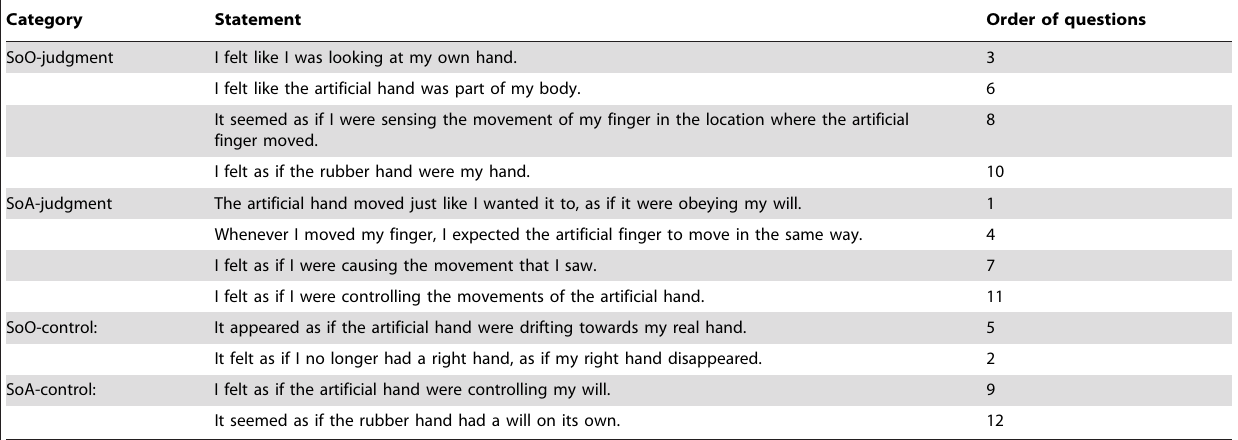
Table 1. Questionnaire for the SoA and